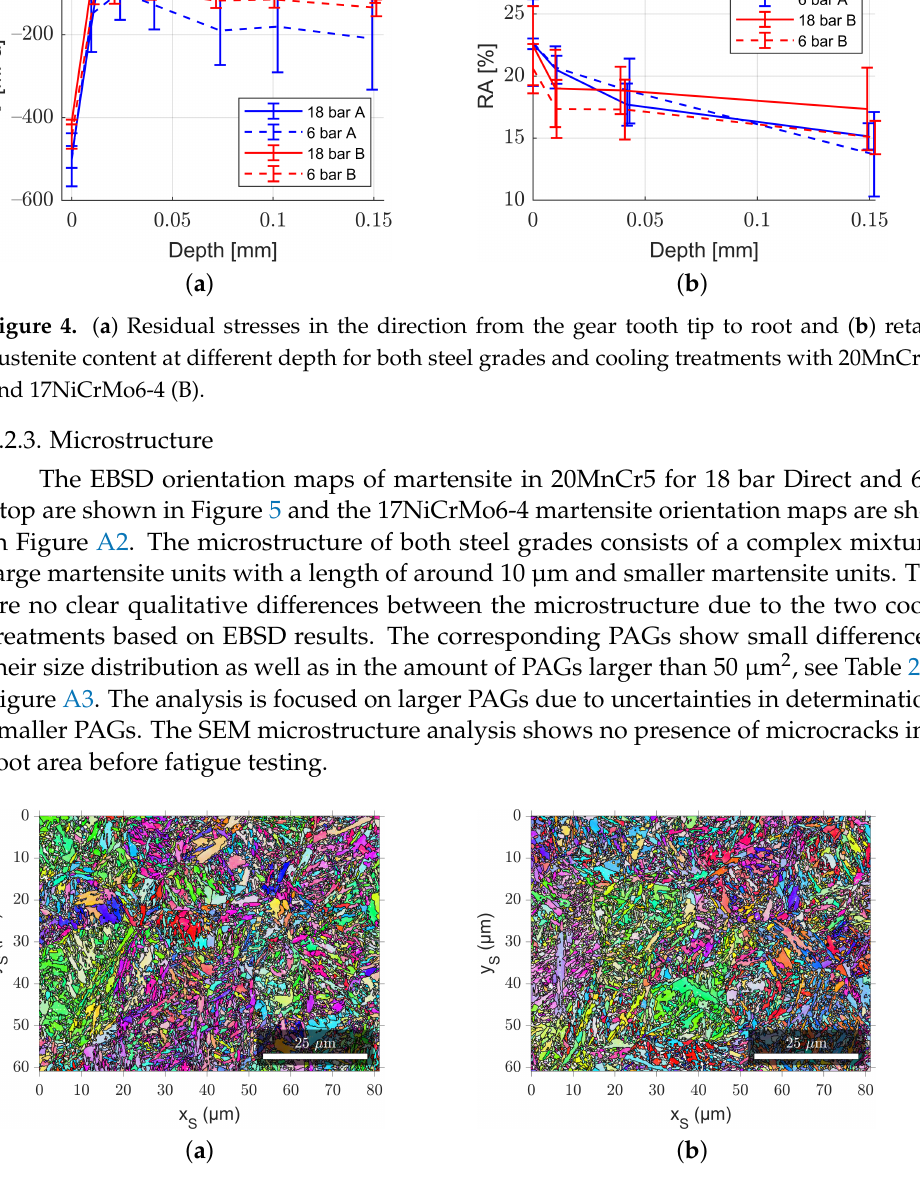
Figure 5. Martensite orientation map of 20MnCr5 (A) ( a ) 18 bar Direct and ( b ) 6 bar Stop close to the surface area of the